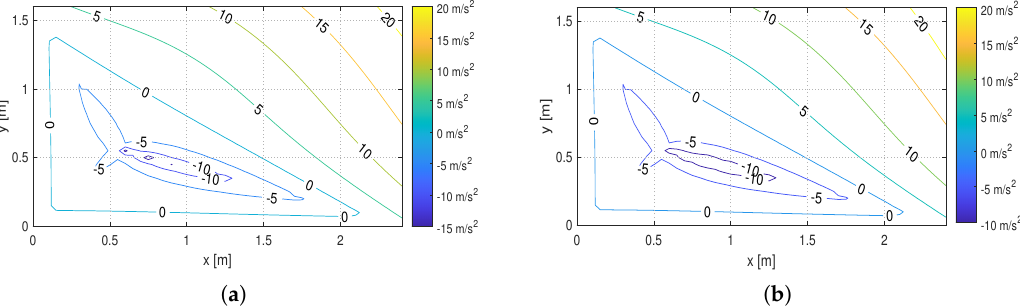
Figure 6. Comparison between the minimum acceleration limits obtained without considering the actuator dynamics ( a ) and considering the actuator dynamics ( b ).